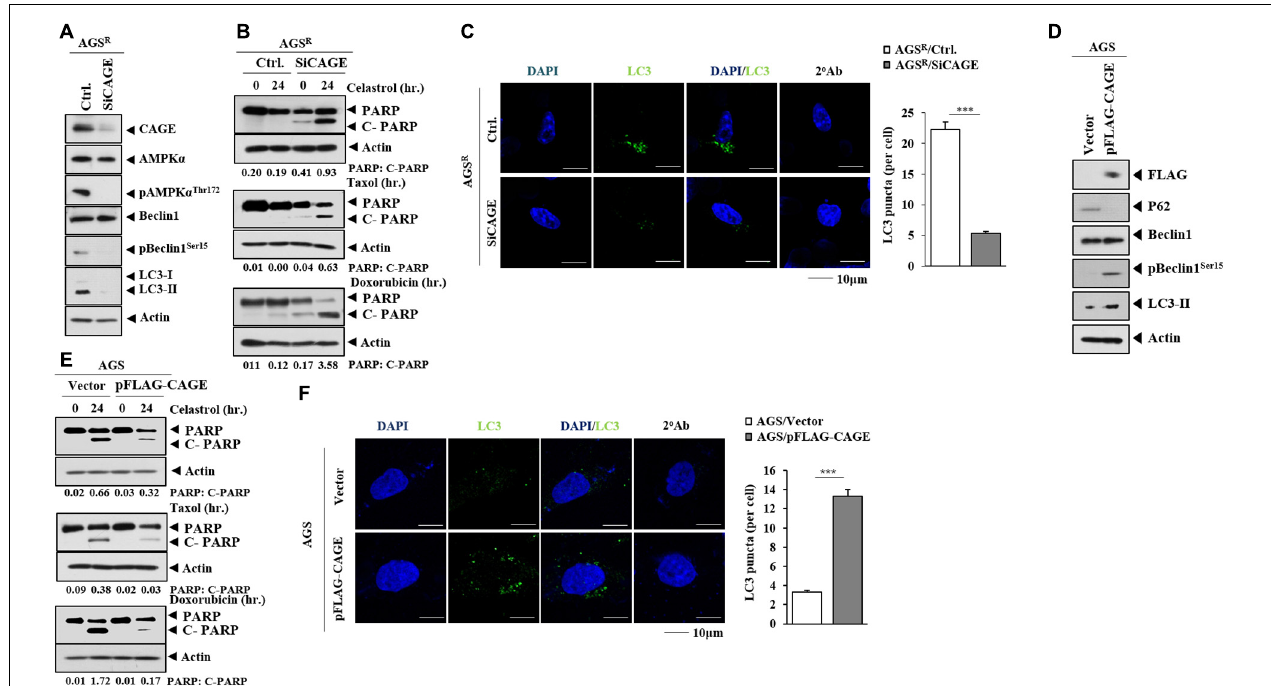
FIGURE 2 | CAGE regulates anticancer drug resistance and autophagic flux. (A) After 48 h of transfection with the indicated siRNA (each at 10 nM), immunoblot was performed. Representative blots of three independent experiments are shown. Ctrl. denotes control siRNA. (B) After 24 h of transfection, cells were treated with the indicated anticancer drug for 24 h. Quantification of band intensity was represented by the ratio of cleaved/full-length PARP normalized to actin. (C) Same as (A) except that immunofluorescence staining was performed. ***, p < 0.001. (D) After 48 h of transfection with the indicated construct, immunoblot was performed. Representative blots of three independent experiments are shown. (E) After 24 h of transfection, the cells were treated with the indicated anticancer drug (each at 1 µ M) for 24 h. (F) Same as (D) except for the immunofluorescence staining.